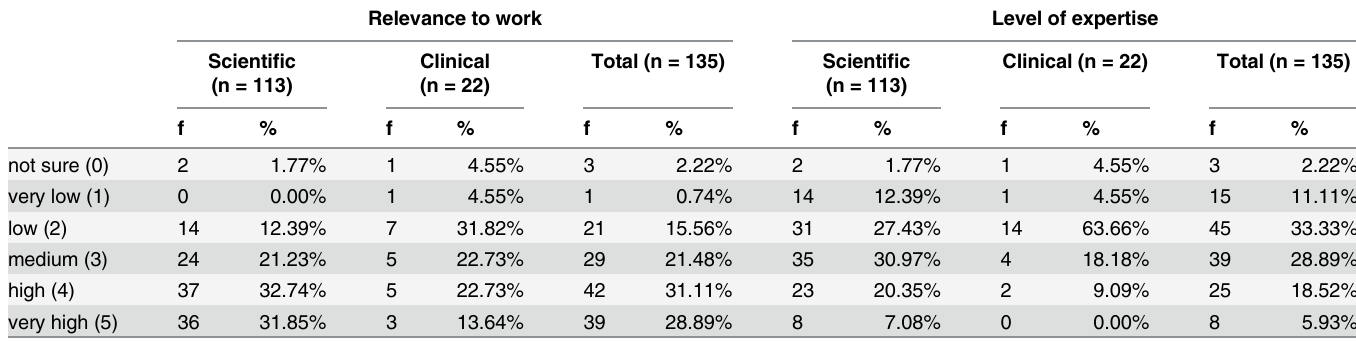
Table 3. Responses to “ Locate and obtain other researchers ’ shared data to use in your research, and clean or process it to meet your research needs. ”